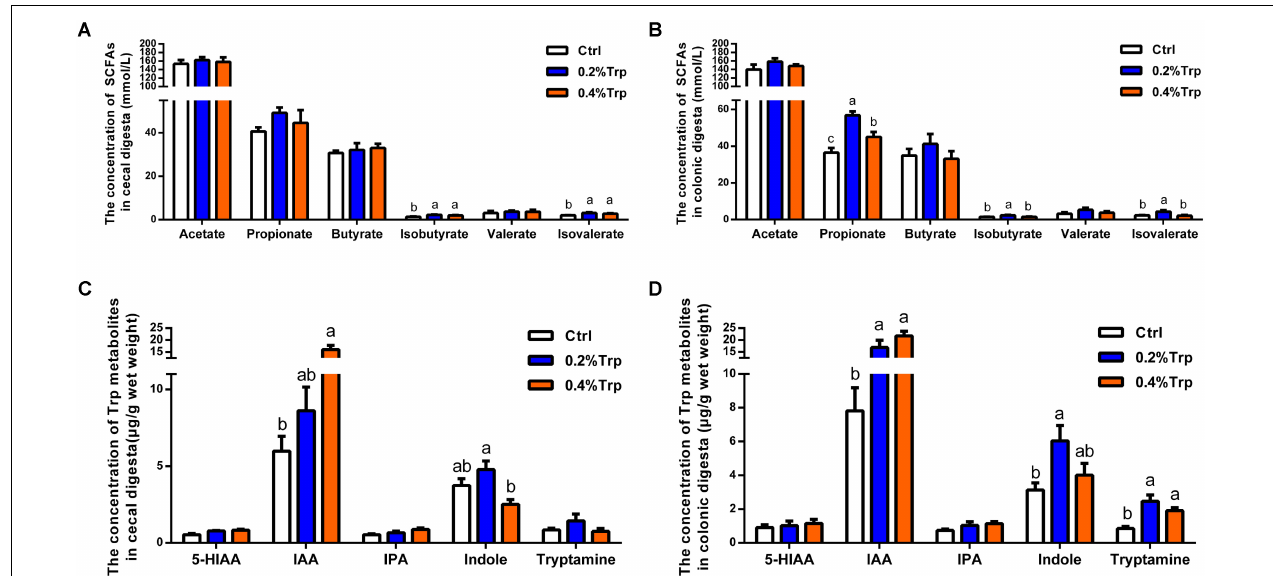
FIGURE 4 | Dietary Trp supplementation promoted the production of SCFAs and tryptophan metabolites in the hindgut of weaned pigs. Data are presented on the concentrations of SCFAs, including acetate, propionate, butyrate, isobutyrate, valerate and isovalerate, in cecal (A) and colonic (B) contents, as well as the concentrations of Trp-derived metabolites in cecal (C) and colonic (D) contents. Values are means ± SEMs, n = 6. Means without a common letter differ, P <